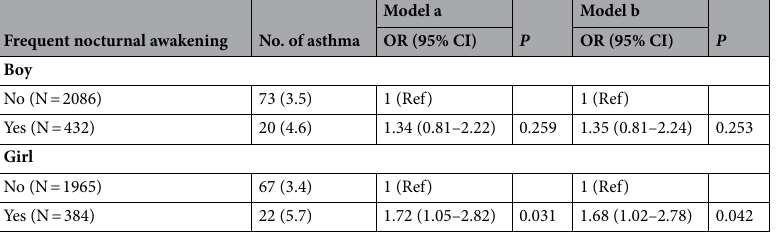
Table 4. Association between frequent nocturnal awakening and asthma according to gender. Model a: Unadjusted. Model b: Adjusted for region, age, mother’s educational level, BMI z-score, delivery mode, birth weight, maternal tobacco exposure during pregnancy, feeding pattern before 6 months.